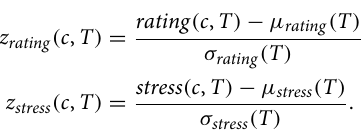
rating ( c , T ) c (cid:30) s average review rating during T , = # c (cid:30) s posts related to stress during T stress ( c , T ) = total # c (cid:30) s posts during T